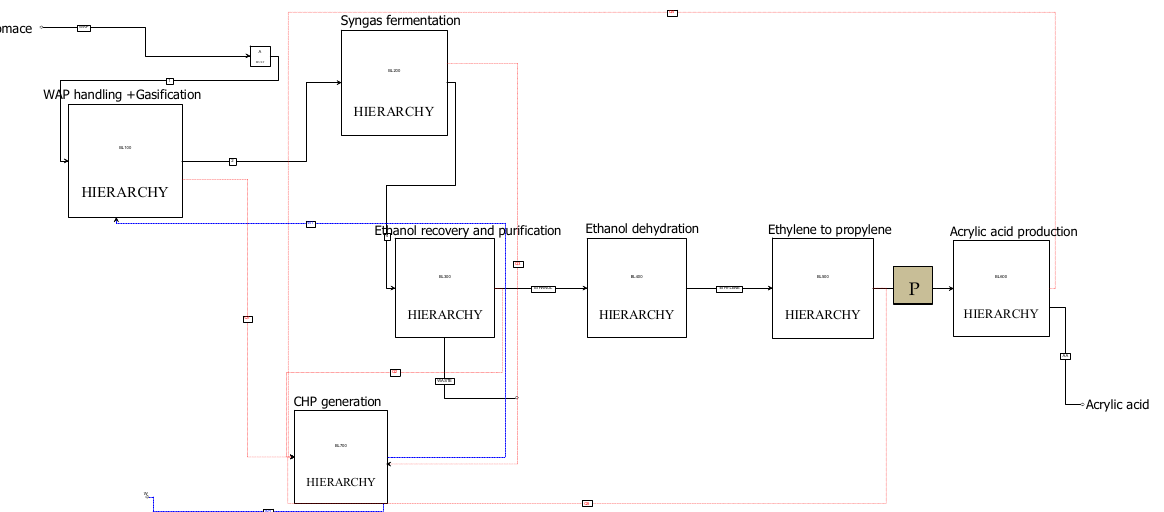
Figure 3. Aspen Plus output for AA production from WAP via the fermentation–dehydration (FD) pathway (black continuous lines, red dash lines and blue dashed line denote material, heat and work flows).